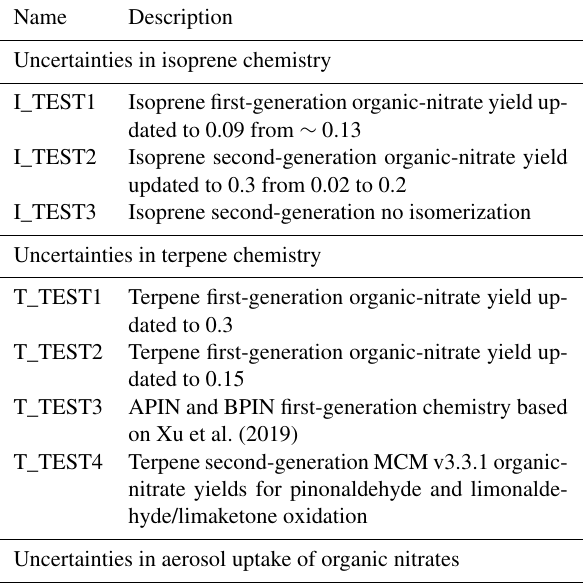
Table 1. Sensitivity tests to determine the impact of uncertainties in TS2 on simulated surface